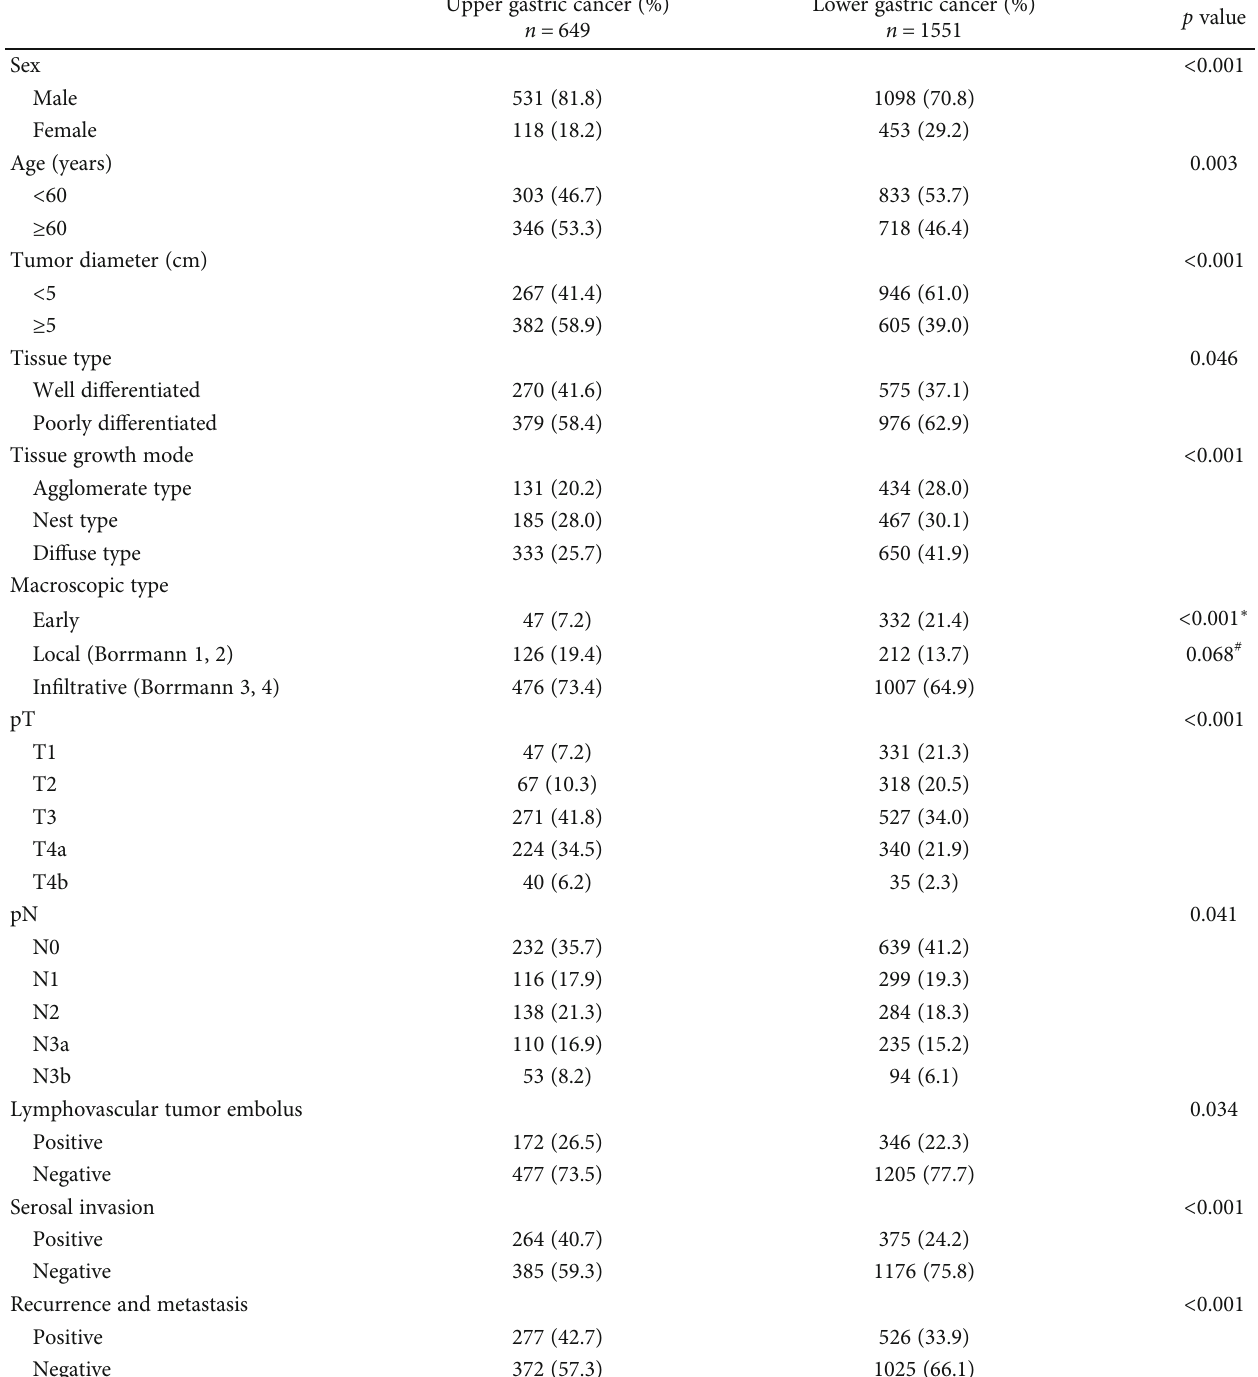
Table 1: Clinicopathological characteristics of patients with upper and lower gastric